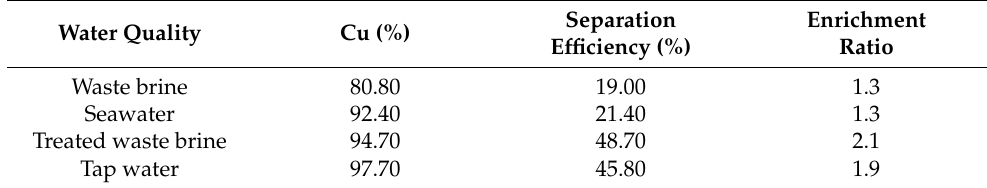
Table 3. Evaluation of the copper flotation process using different water qualities. Water Quality Cu